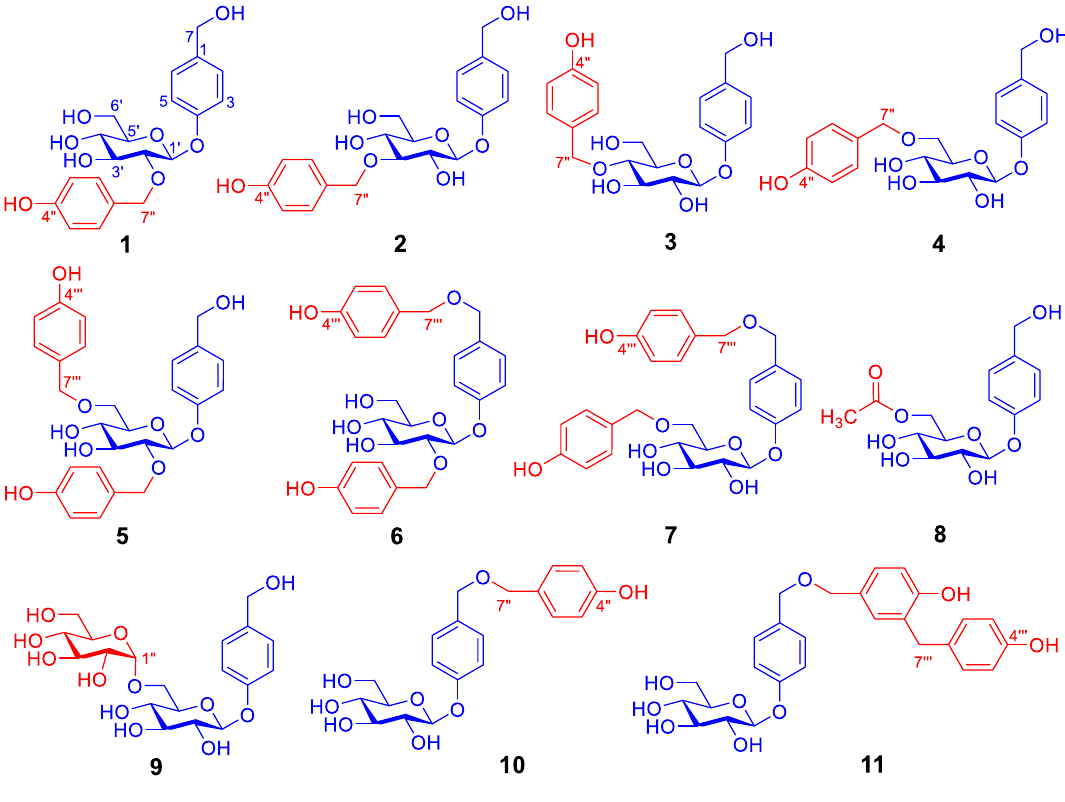
Fig. 1 Structures of compounds 1 –